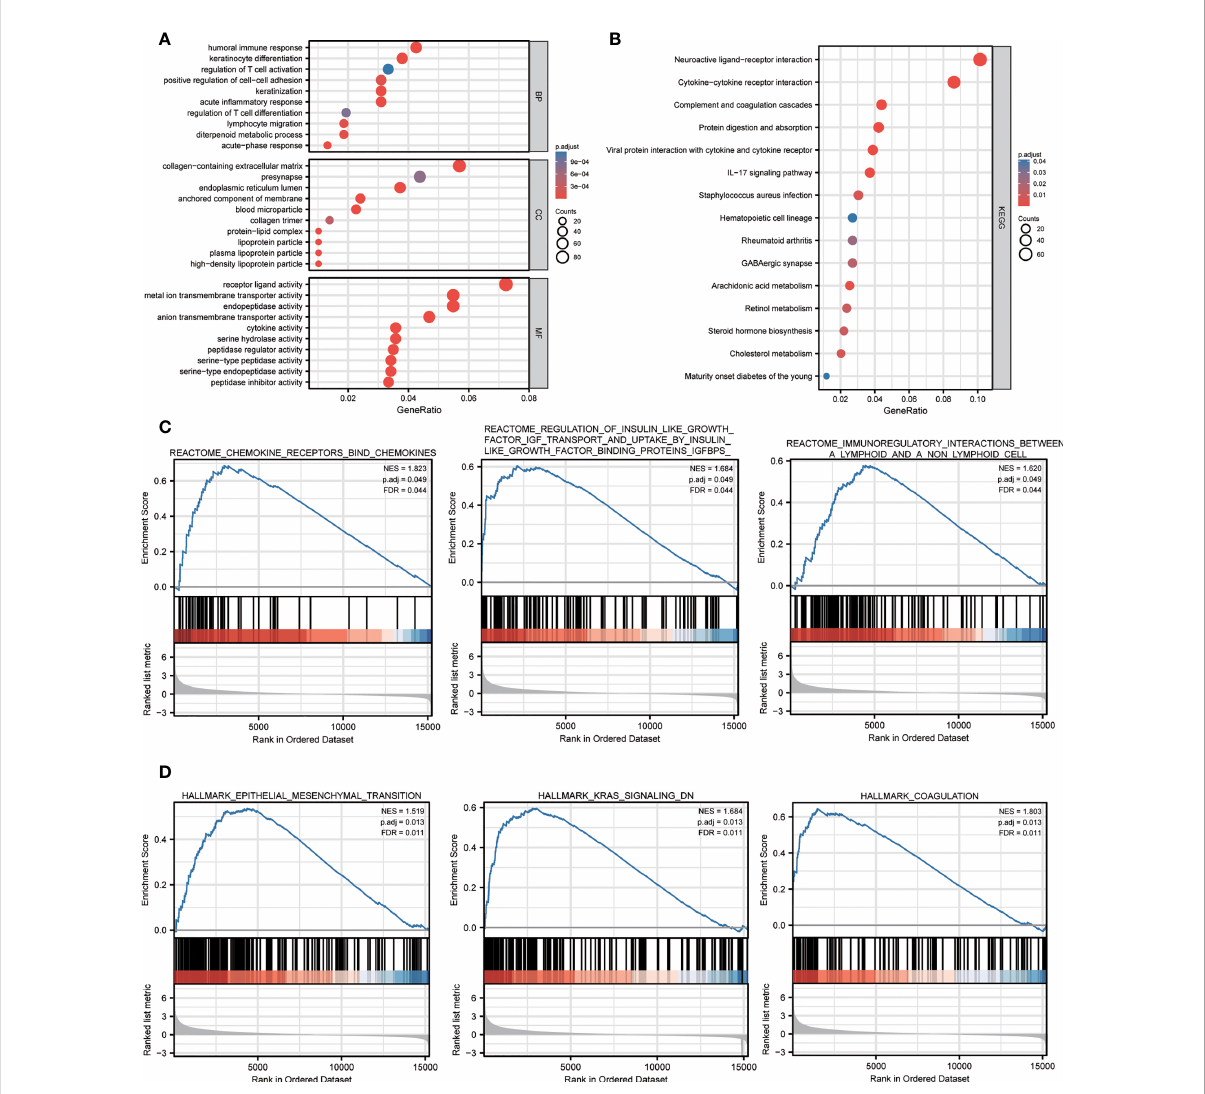
FIGURE 4 Functional annotation of the DEGs between high- and low- NPG score groups. (A) The GO analysis with GO terms of biological processes, cell components, and molecular functions. (B) KEGG pathway enrichment analyses of DEGs between high- and low- NPG score groups. (C, D) GSEA analysis of tumor progression and immunity between low- and high- NPG score